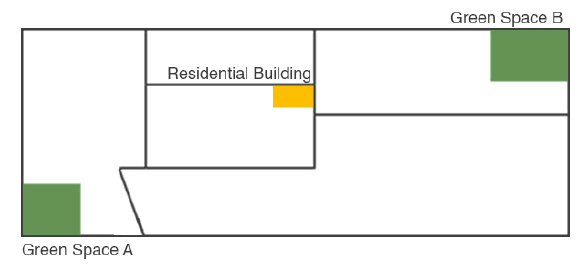
Figure 7. Travel distance calculated with travel time and speed impacted by the slope